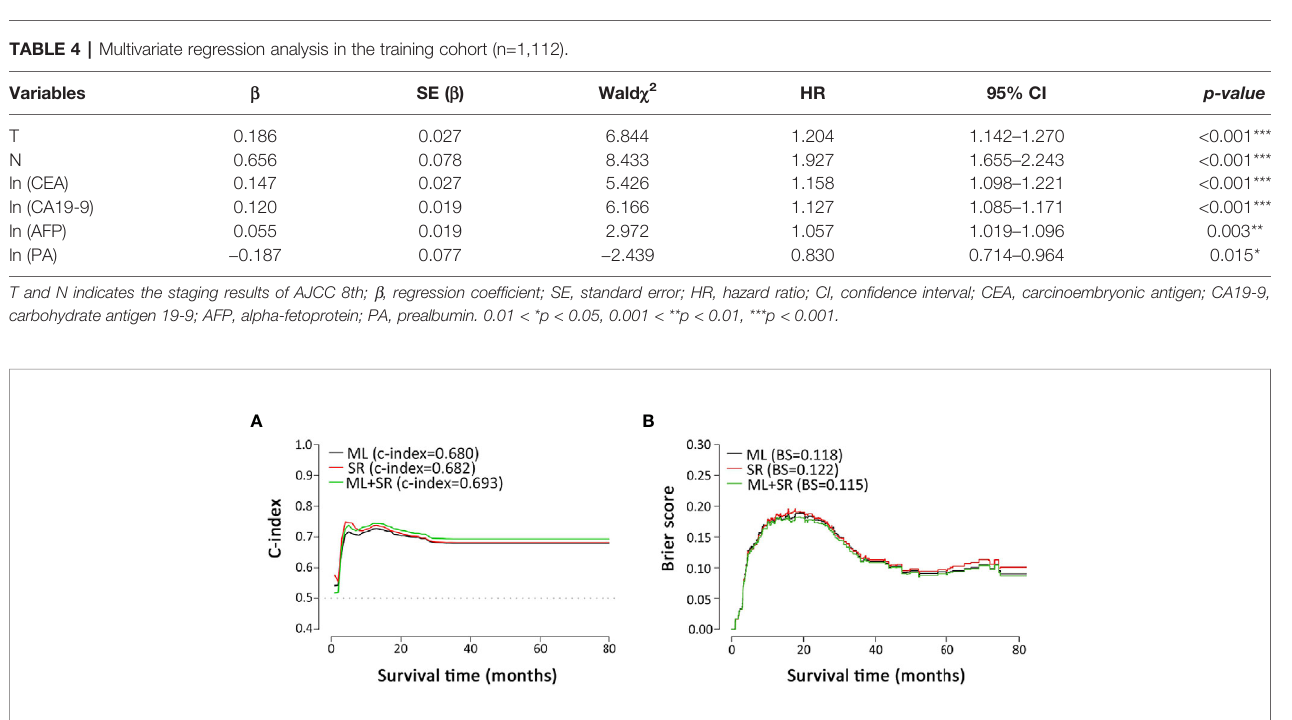
FIGURE 2 | Metrics comparison of models based on different multivariate analysis approaches. (A, B) are C-index and brier score comparisons of models based on multivariate analysis by ML, SR, and ML+SR, respectively. ML, machine learning; SR, stepwise regression.